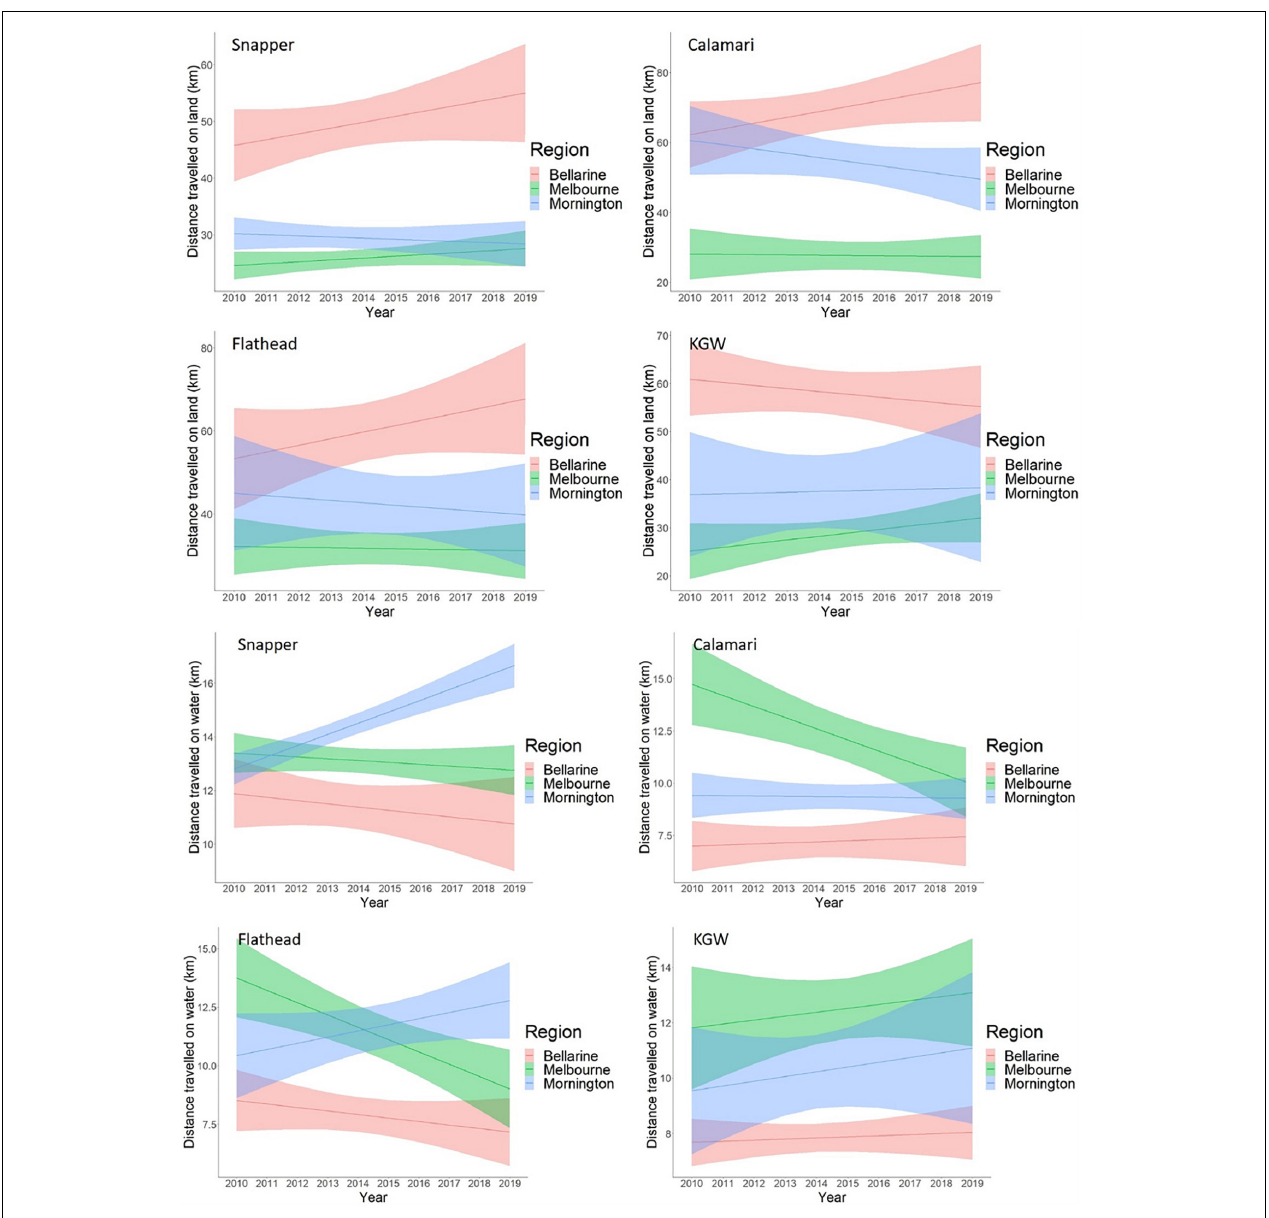
FIGURE 9 | GLM plots of temporal trends in the anglers’ average travel distance (km) on land and on water by residential region and target species. Shaded areas represent the 95% confidence